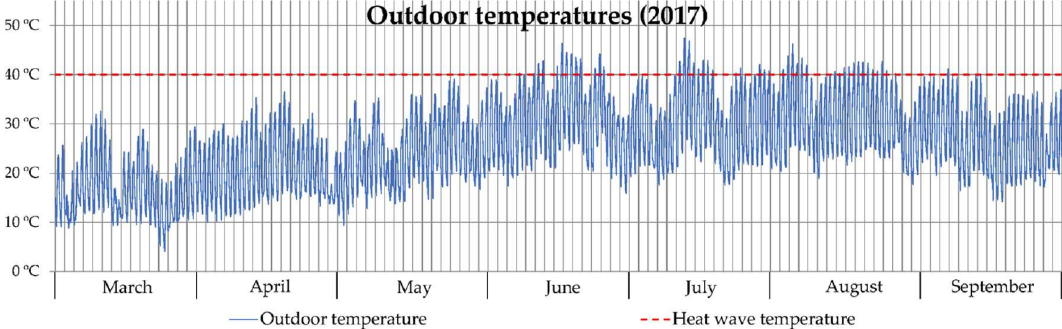
Figure 1. Outdoor temperatures from March to September in Seville, registered by the weather station placed above the test